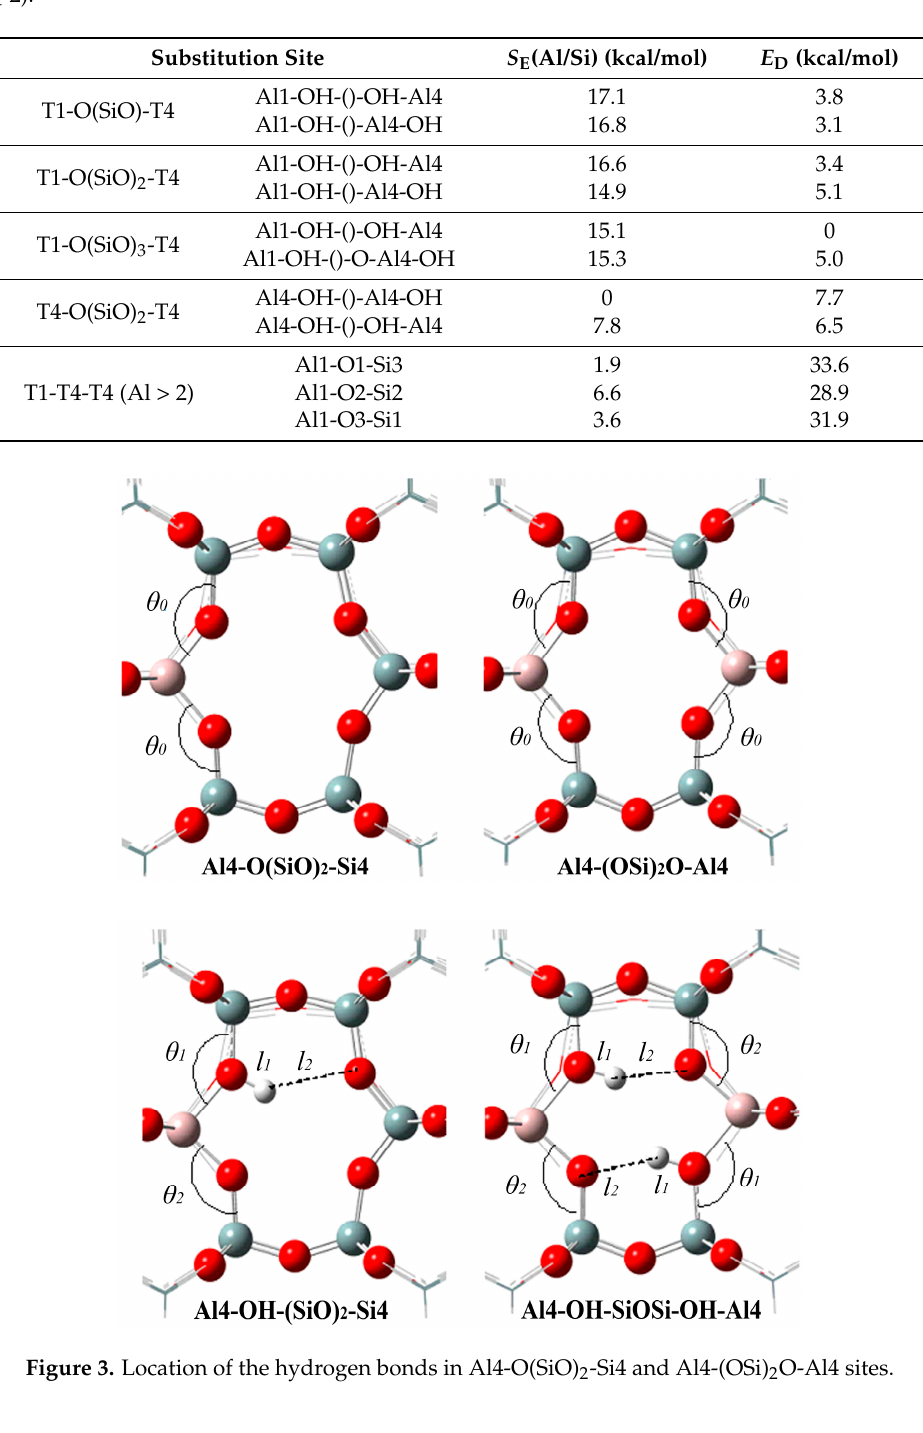
Table 2. Characterization of stability and acid strength of Brönsted acid sites calculated on n -Al models ( n ≥ 2).